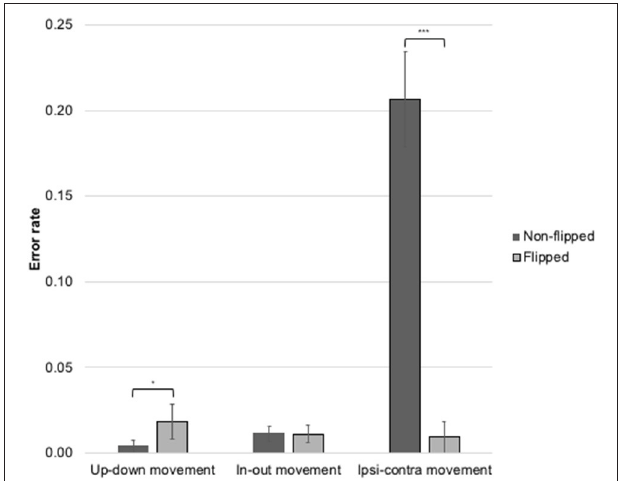
FIGURE 7 | Error rates on movement types in the flipped and non-flipped conditions. Subjects were sign-naive undergraduates. *** p < 0.001, * p =